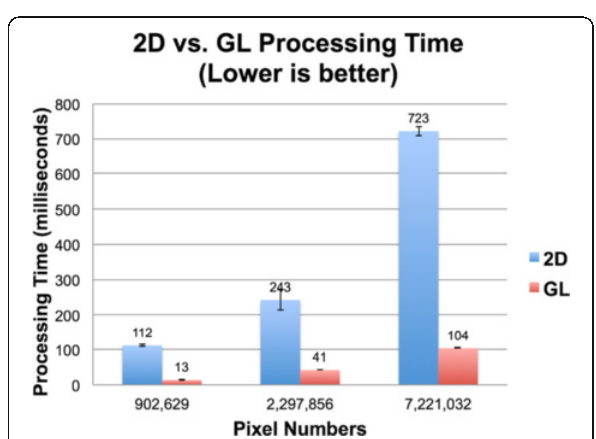
Fig. 7 (abstract A7). Image of WebGL vs. Canvas Comparison. Shows a comparison of processing time as a function of the number of image pixels in JavaScript (blue) and WebGL (red). WebGL shows a factor of six to eight